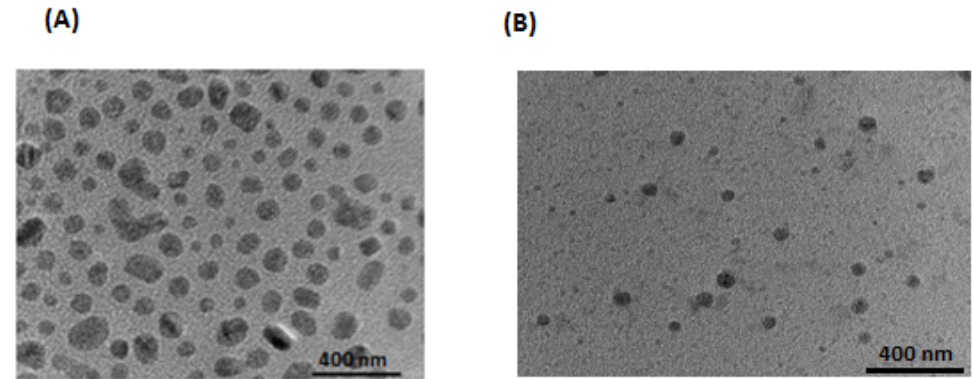
Figure 4. Transmission electron microscopic image of Dox–Erlo NPs ( A ), Dox–Erlo NPs conjugate ( B ).